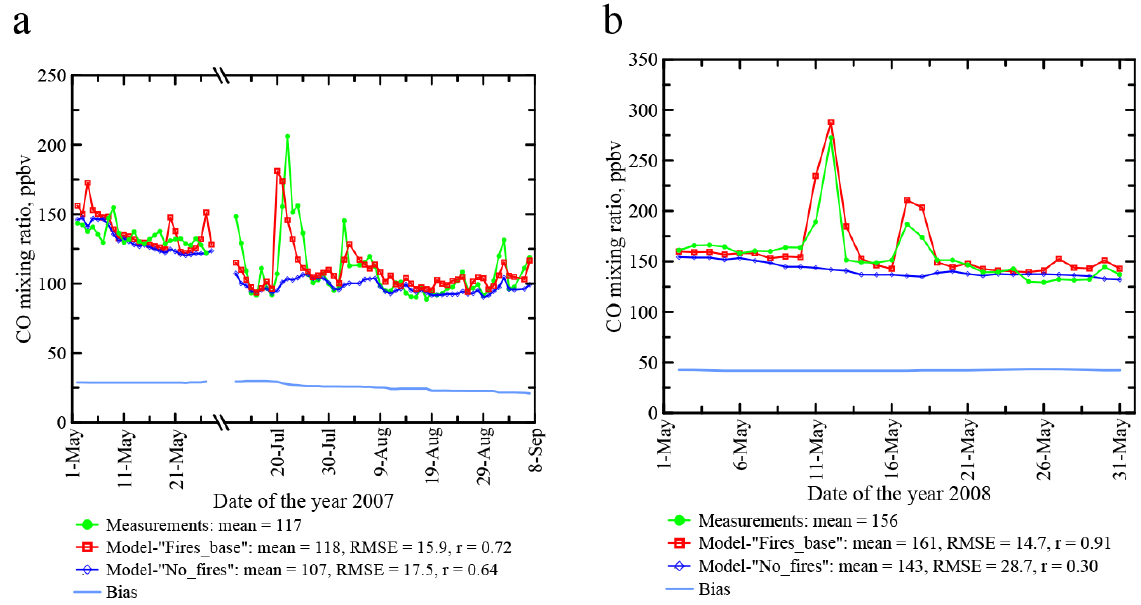
Figure 8. Comparison of the daily mean CO concentrations measured at the ZOTTO monitoring site with corresponding simulations (after debiasing) performed by CHIMERE without (“No_fires”) and with (“Fires_base”) fire emissions: the data are for the years (a) 2007 and (b) 2008. The “bias” shown by the solid blue line was estimated as the running average (over 30 days) of the difference between the measurements and simulations in the “No_fires” case for the days when the impact of fires was negligible (when the difference between the simulated concentrations in the “Fires_base” and “No_fires” did not exceed 10%); all other days (with noticeable contribution of fires) were used for evaluation of the statistics reported below the figures.